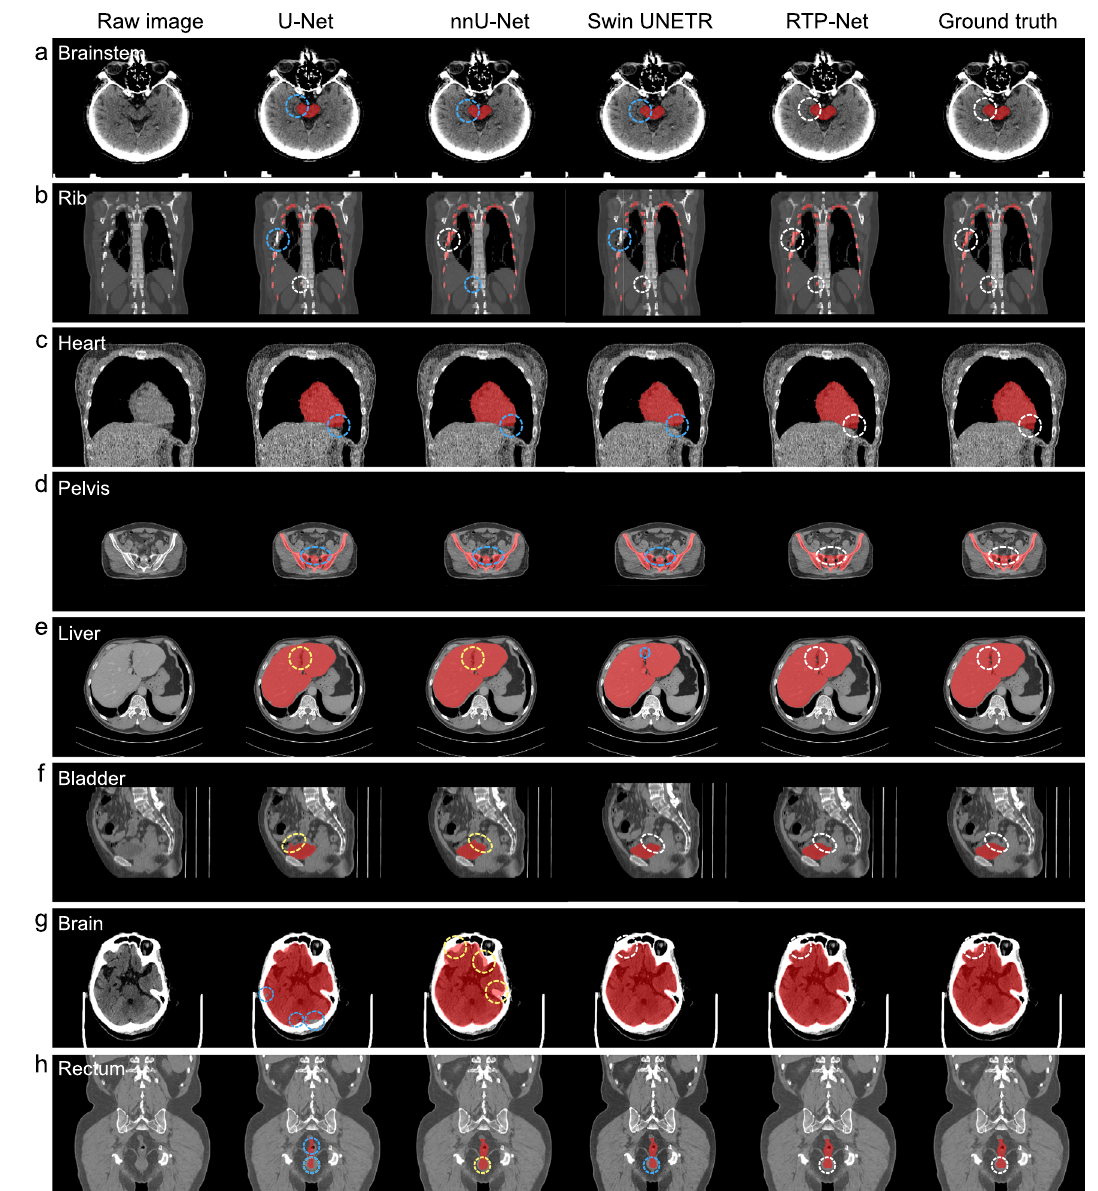
Fig. 4 | Visualcomparisonofsegmentationperformance ofour proposedRTP- Net,U-Net,nnU-Net,andSwinUNETR. SegmentationisperformedoneightOARs, i.e.,( a )brainstem,( b )rib,( c )heart,( d )pelvis,( e )liver,( f )bladder,( g )brain,and( h )